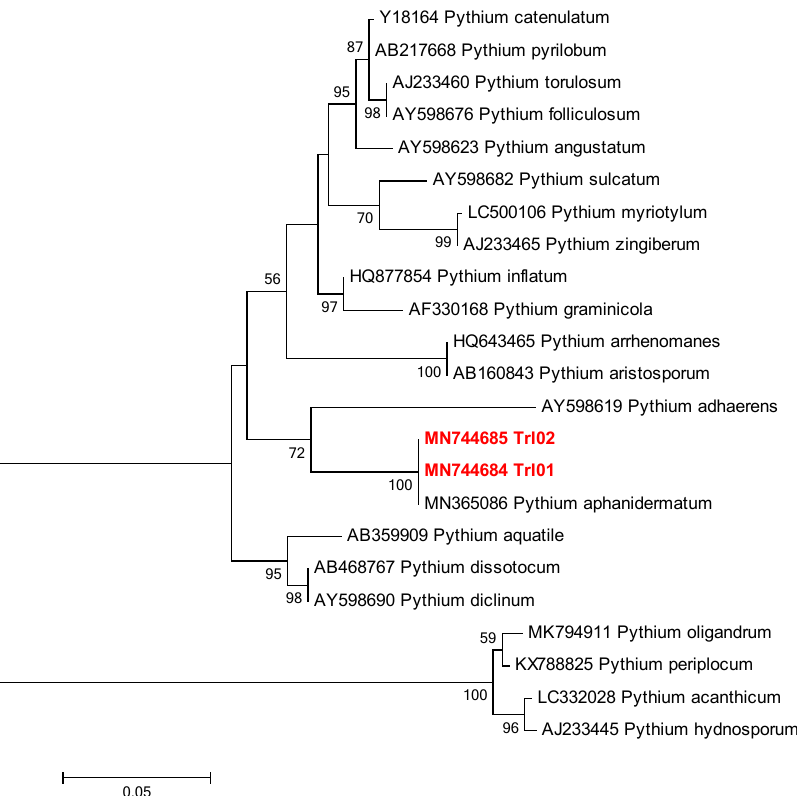
Figure 7: Molecular Phylogenetic analysis by Maximum Likelihood method. The percentage of trees in which the associated taxa clustered together is shown next to the branches. The tree is drawn to scale, with branch lengths measured in the number of substitutions per